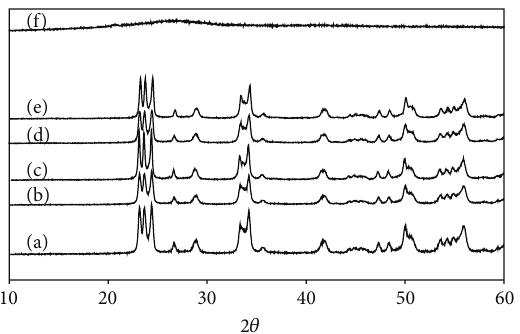
Figure 4: N 2 adsorption/desorption isotherms of (a) WO 3 -Ppy-20 nanocomposite, (b) Pure Ppy, and (c) WO 3